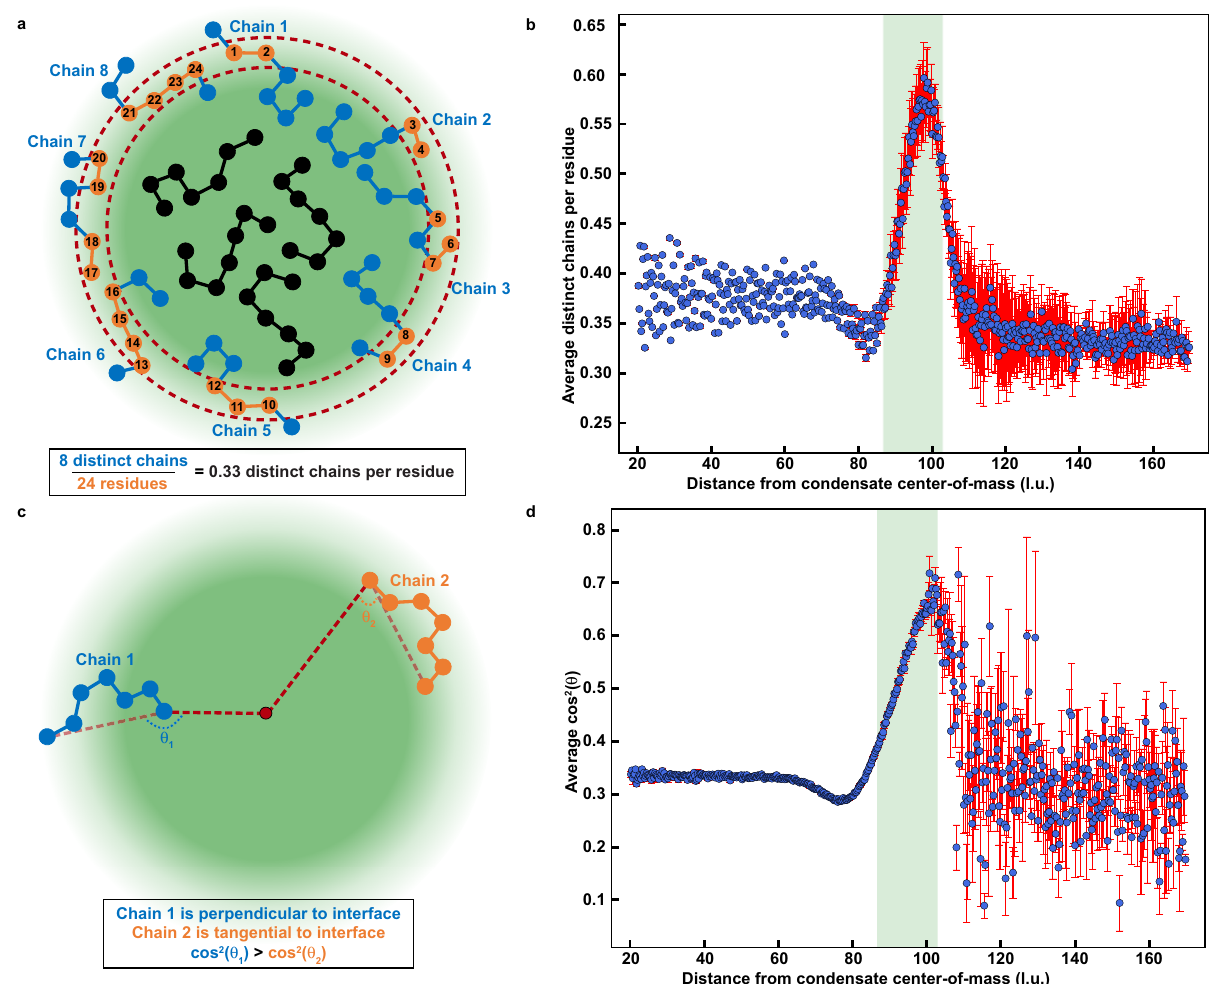
Fig. 5 | At the interface, molecules have non-random, perpendicular orienta- tions. a A diagram depicting how distinct chains per residue is calculated. The region enclosedby the dashed red curves indicates the radial shell of interest. Any chainsthatcontainbeadswithintheradialshellarecoloredblue.Anybeadsthatare within the radial shell are colored orange. All other chains are colored black. To calculatethedistinctchainsperresidue,thenumberofbluechainsisdividedbythe numberoforangebeads,inthiscase8and24,givingaparametervalueof0.33.This parametercanvarybetween0and1.Lowervaluessuggestthatchainsarewrapped around a radial shell, whereas higher values suggests that chains are oriented perpendiculartoaradialshell. b Averagedistinctchainsperresidueplottedagainst the distance from the condensate center-of-mass for the wild-type A1-LCD at ω = − 3.38. c A diagram depicting how the parameter cos 2 θ is calculated. Here, θ is de fi ned as the angle swept out by a line segment (translucent dashed red line)